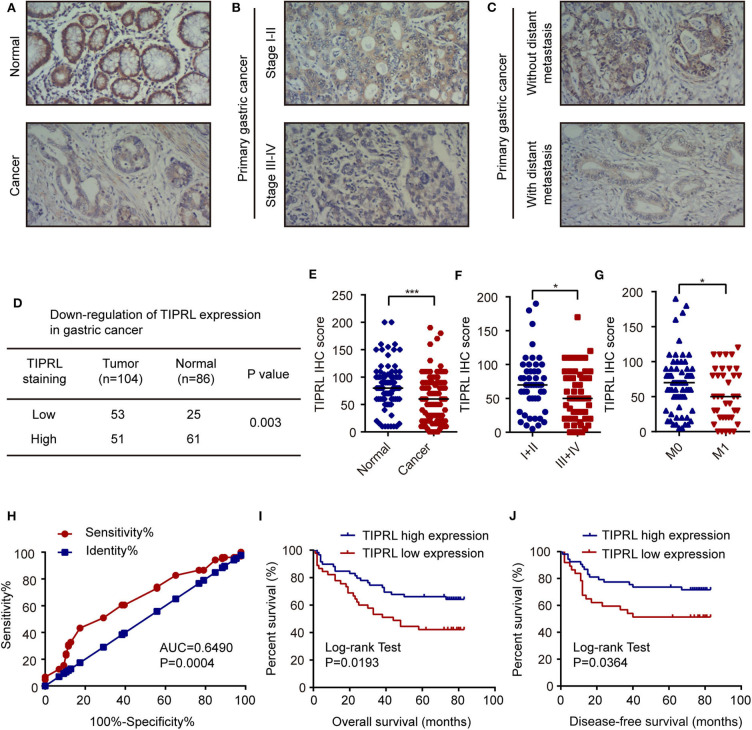
Decrease of TIPRL expression correlates with a poor clinical outcome in gastric cancer. (A–C) Representative immunohistochemical staining for TIPRL expression in normal gastric tissues, gastric cancer with different TNM tumor stages (I-II vs. III-IV) and gastric tumors with or without distant metastasis (M0 vs. M1). Original magnification, × 100. (D) Statistical analysis of TIPRL expression in gastric cancer tissues. (E) Quantitative analysis of TIPRL staining indicated that staining intensity in gastric tumors was significantly lower than normal gastric mucosa (t-test, ***P < 0.001). (F) TIPRL expression was dramatically decreased in patients at advanced stages (III-IV), in contrast with those at earlier stages (I-II) (t-test, *P < 0.05). (G) Analysis of TIPRL staining intensity also showed lower staining intensity in patient samples with distant metastasis (M1) compared to those without distant metastasis (M0) (t-test, *P < 0.05). (H) The ROC curves demonstrated strong separation between normal and gastric cancer tissues [AUC = 0.6490, CI (95%): 0.5709–0.7270, P = 0.0004]. The sensitivity and specificity of TIPRL expression to distinguish normal from gastric cancer tissues were 43.27 and 82.56%, respectively. (I,J) Kaplan–Meier survival curves revealed that low intensity of TIPRL immunostaining strongly correlated with poor overall survival (I, log-rank test, P = 0.0193) and disease-free survival (J, log-rank test, P = 0.0364).